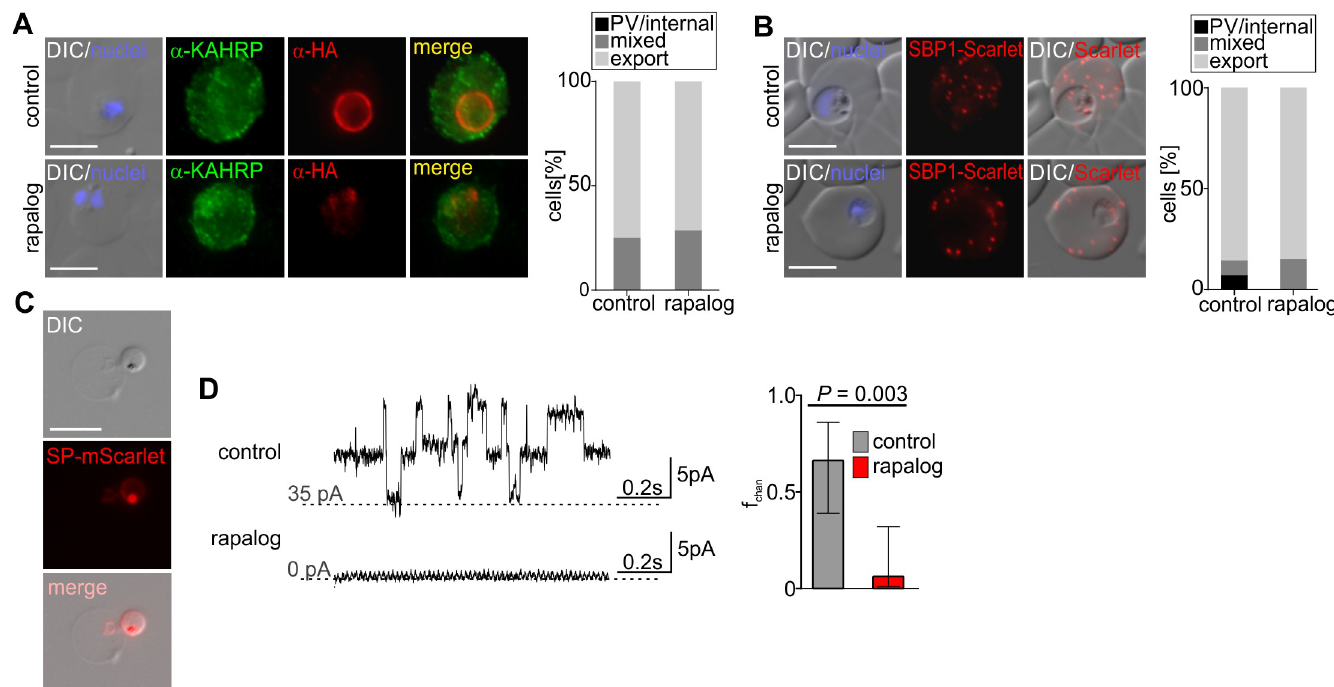
Fig 5. PVM nutrient-permeable channel but not protein export is impaired in Δ EXP1 parasites. (A) IFA images of control and Δ EXP1 parasites (rapalog) probed with α -HA (EXP1 � -HA) and α -KAHRP. Graph to the right shows quantification of export ( n = 20 cells). See S5C Fig for other exported proteins. (B) Live cell imaging of control and Δ EXP1 parasites (rapalog) expressing SBP1-mScarlet. Graph to the right shows quantification of export ( n = 20 cells). (C) Live cell images of a Δ EXP1 trophozoite expressing SP-mScarlet liberated from its host RBC. (D) Left, current recorded from liberated control and Δ EXP1 parasites (rapalog) at 30 mV applied potential to the pipette electrode. Scale bar shows time in seconds and current in pA. The dotted line indicates a current reference level. At 30 mV, the PVM channels have an open probably of about one-half, therefore the flicker is offset in the control example as multiple channels are in the recording. The shown recordings are representative of the experiments done in each condition and show 1-second details from longer recordings to resolve the typical channel flicker in print. Right, probability of detecting at least one PVM channel per sealed patch (f chan ) in Δ EXP1 parasites (rapalog, n = 14) and controls ( n = 12). Fischer’s exact test was used to estimate P value. Error bars indicate SD. In (A) and (B), nuclei were stained with DAPI; scale bars: 5 μ m. DIC, differential interference contrast; EXP1, exported protein 1; HA, triple hemagglutinin tag; KAHRP, knob-associated histidine-rich protein; pA, Picoampere; PSAC, parasite surface anion channel; PVM, parasitophorous vacuolar membrane; RBC, red blood cell; SBP1, skeleton binding protein 1.